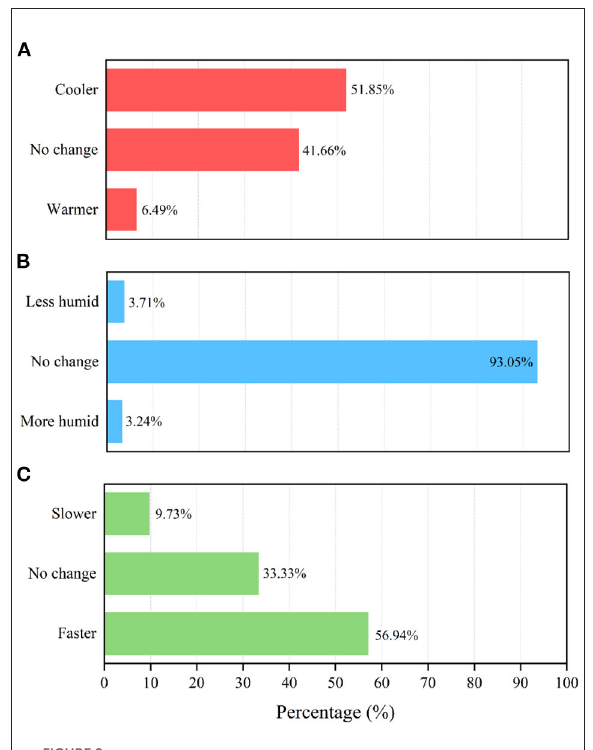
FIGURE8 Results of indoor thermal environment parameter preference